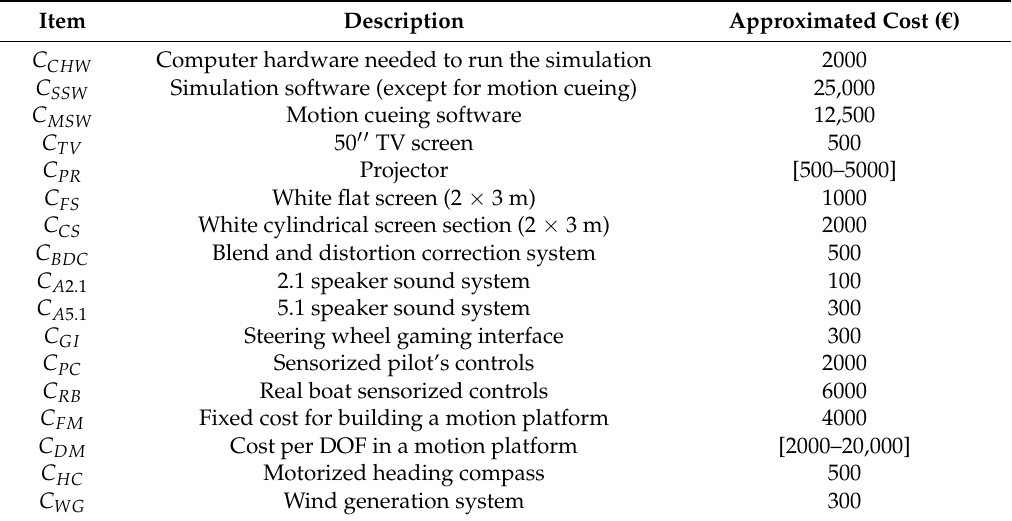
Table 1. Setups’ items and their approximate